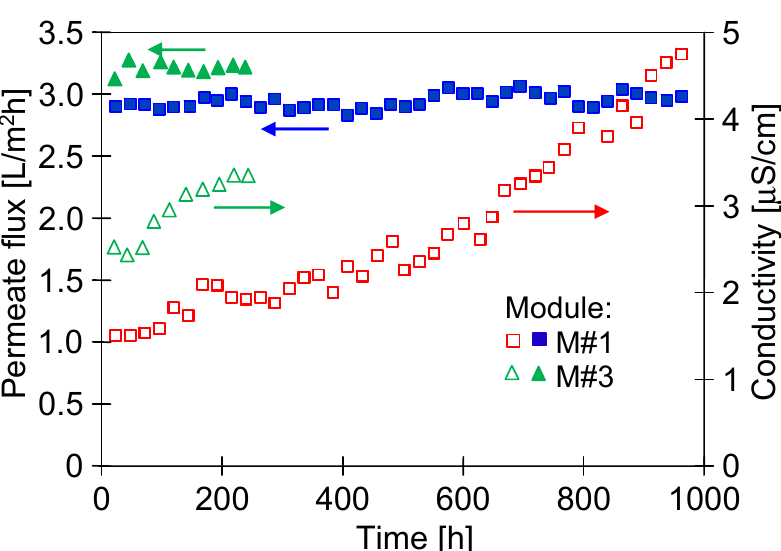
Figure 11. Changes in the permeate flux and distillate conductivity during the MD process. Feed: NaCl solution (35 g/L). T F = 60 °C, modules M#1 and M#3.